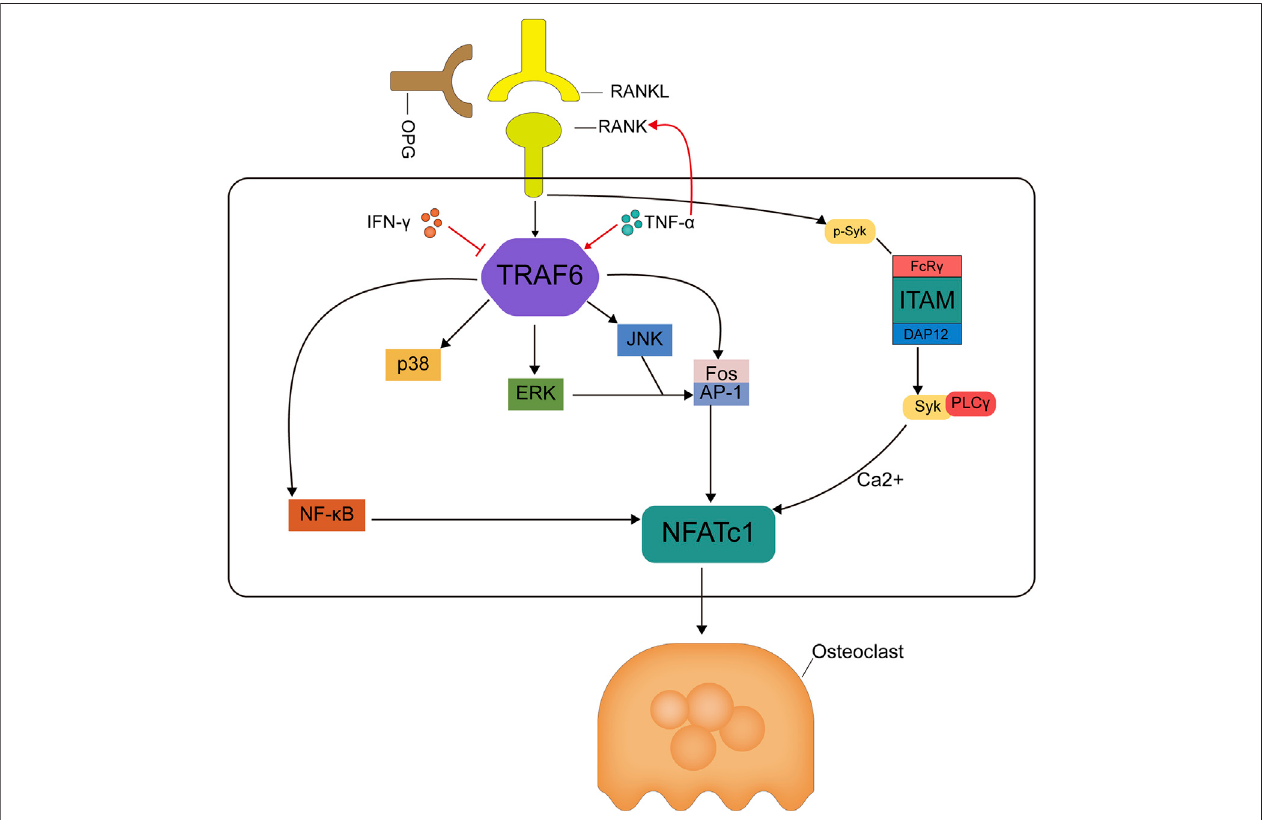
FIGURE4| TCMforthetreatmentofosteoporosis. (A,B) Theimageof PsoraleacorylifoliaLinn and EucommiaulmoidesOliver ,bothofthemarethemonarchdrugs of Qing ’ E formula; (C) The 2D chemical structure of bakuchiol, which is one of the main components in Psoralea corylifolia Linn. (D) showed the six main mechanisms that bakuchiol exerts